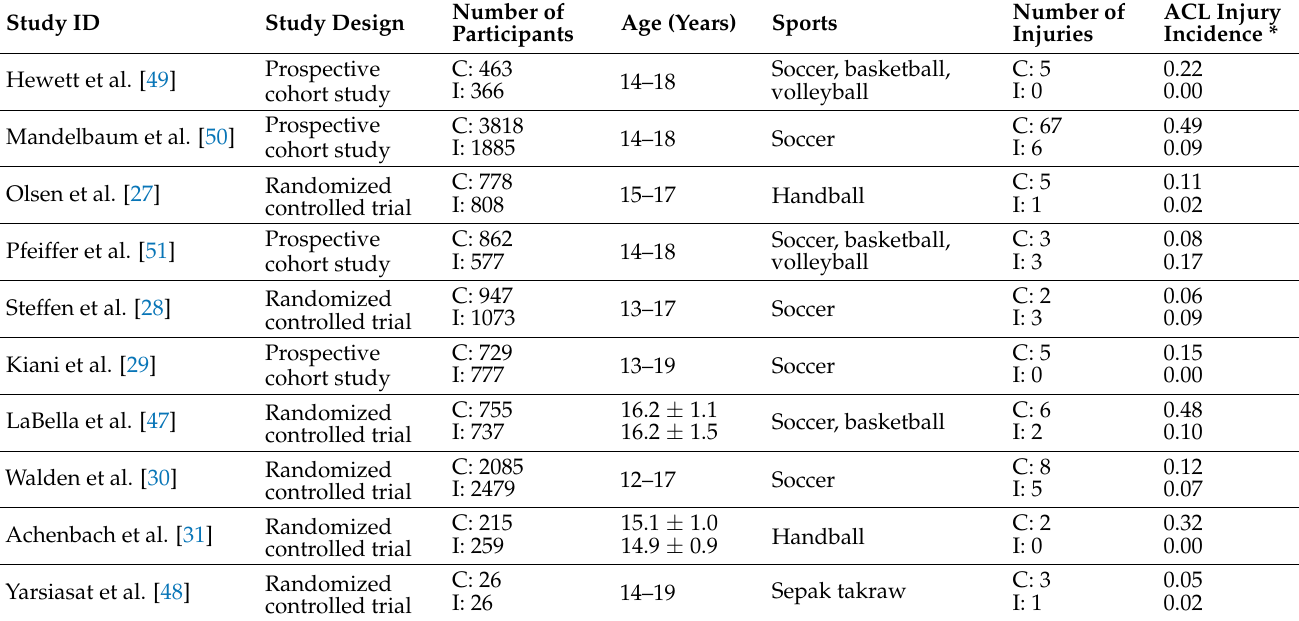
Table 4. Characteristics and injury results of all primary